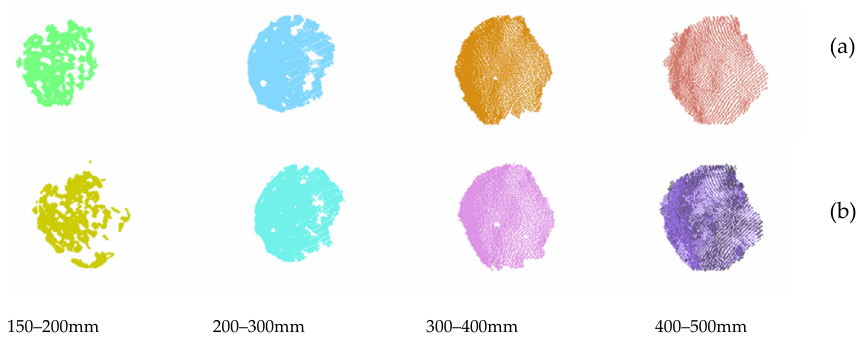
Figure 7. The acquisition setup for the very-close range evaluation test: the camera is mounted on a tripod facing the linear guide on which the sphere moves. Figure 8. ( a ) The point clouds of the sphere acquired at increasing distance with maximum laser power (360 mW); ( b ) the point clouds of the sphere acquired at increasing distance with a laser power of 250